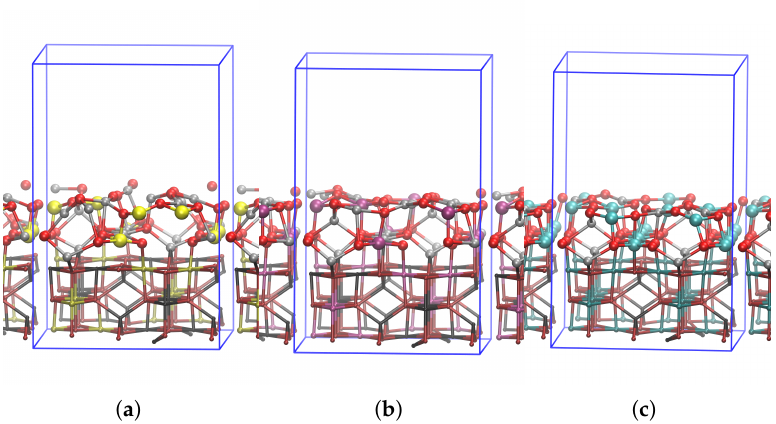
Figure 1. ( a – c ) lSpinel structures of the models used in simulations. Silicon, Titanium, Aluminum, Zinc and Oxygen are depicted in yellow, magenta, blue, gray and red, respectively. Three bottom layers that have been frozen in the simulations are shown in darker shade and as cylinders. Top two layers that were allowed to relax are shown in lighter shade in CPK representation. Blue frames represent the periodic box